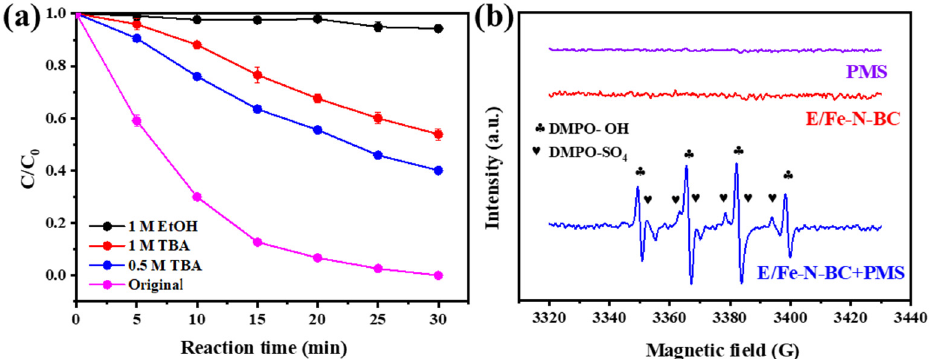
Figure 5. The effects of scavengers on the degradation of QNC in the E/Fe–N–BC/PMS system ( a ), EPR spectra of PMS, E/Fe–N–BC, and E/Fe–N–BC /PMS ( b ). Reaction condition: [QNC] = 10 mg/L, [catalyst] = 0.3 g/L, [PMS = 0.8 mM], pH = 4.2, T = 25 ± 1 °C.